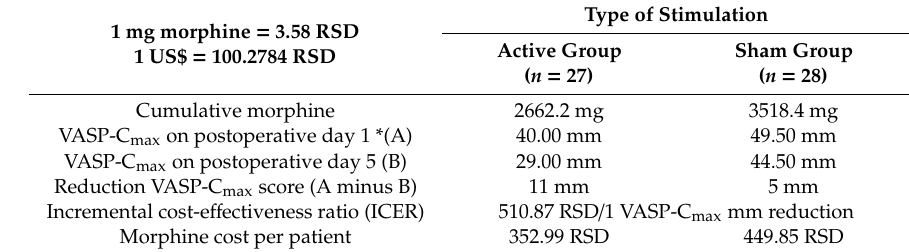
Table 1. Utility and expenditure of morphine cost in patients where active or sham transcranial direct current stimulation was used for post-thoracotomy pain treatment.